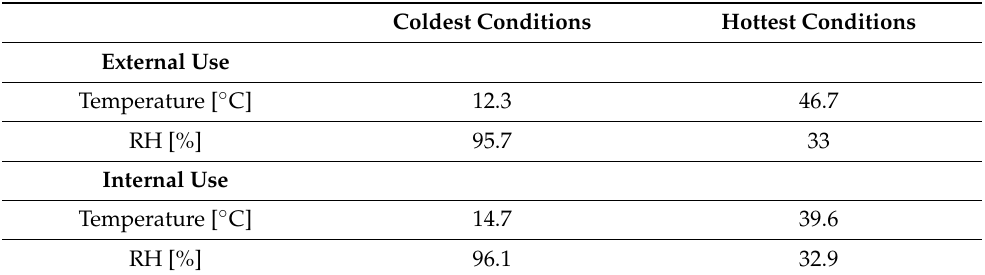
Table 2. Average extreme conditions.